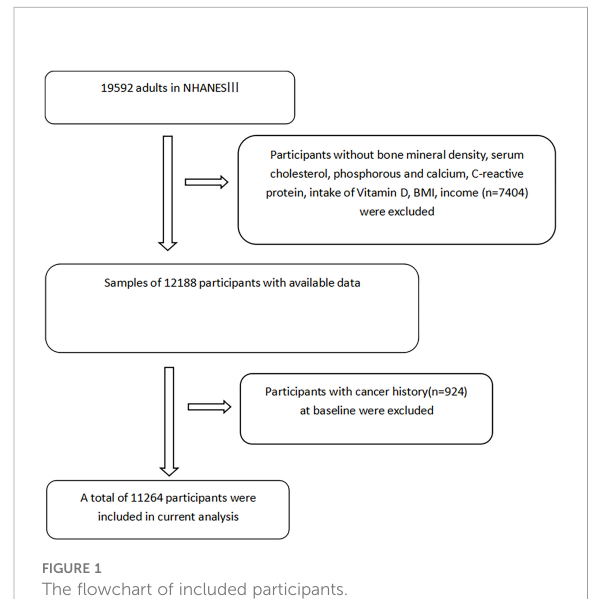
FIGURE 1 The fl owchart of included